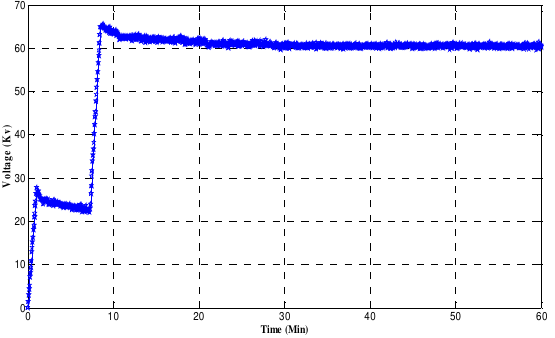
Fig. 13. Output data from the designed